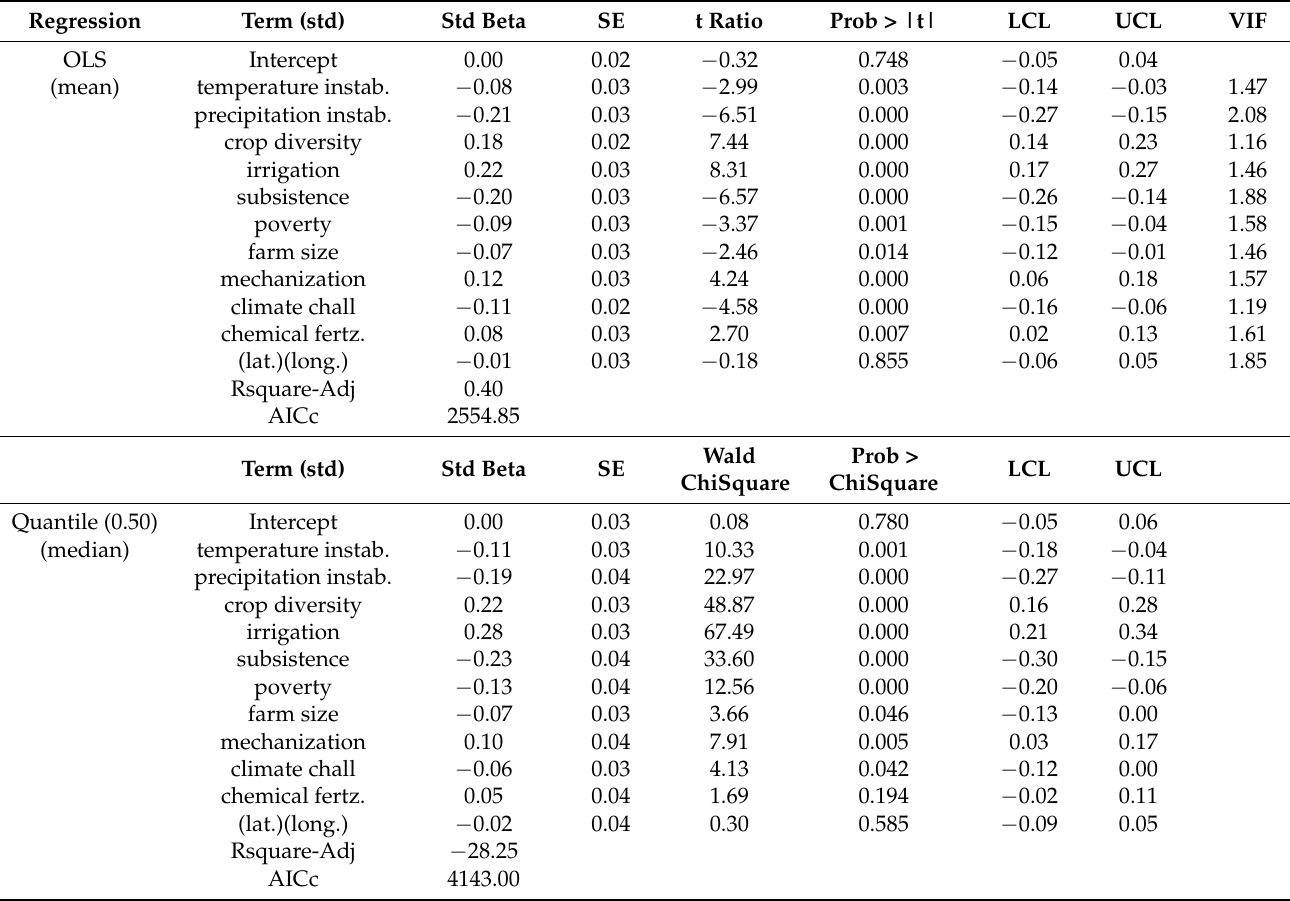
Table A3. Results of Model 2, ordinary least squares (OLS) and quantile (median)